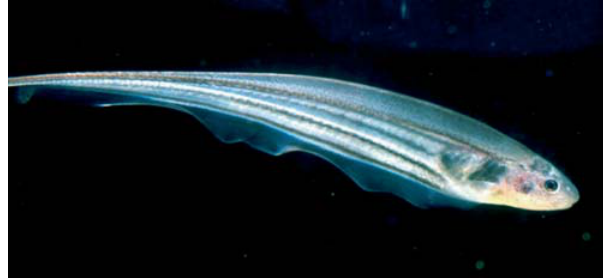
Fig 6. Living specimen of Eigenmannia vicentespelaea with relatively well developed eyes and translucent aspect. Note the three longitudinal stripes (LEA: 121.9 mm). Photo: José